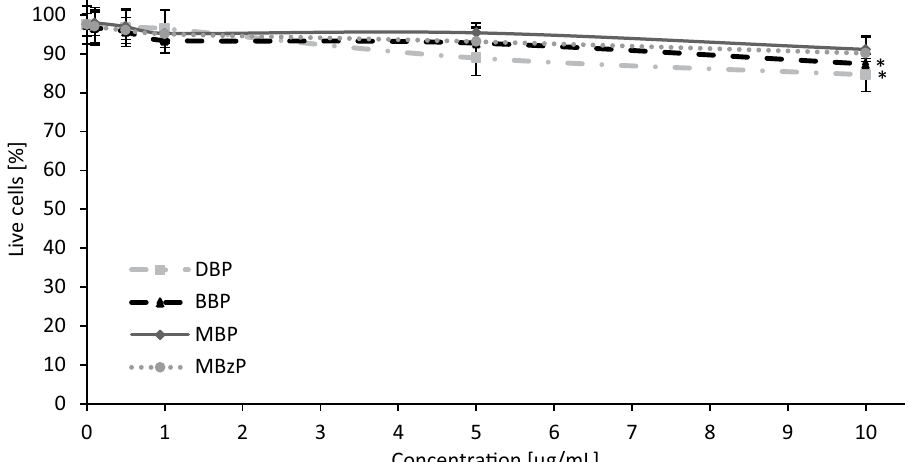
Figure 6. Changes in viability of human PBMCs determined by Trypan Blue dye exclusion test. The cells were incubated with phthalates (0.1–10 µg/mL) for 24 h. (*) Statistically significant different from control (p < 0.05). Each value represents the mean ± SD calculated from 5 individual experiments (5 blood